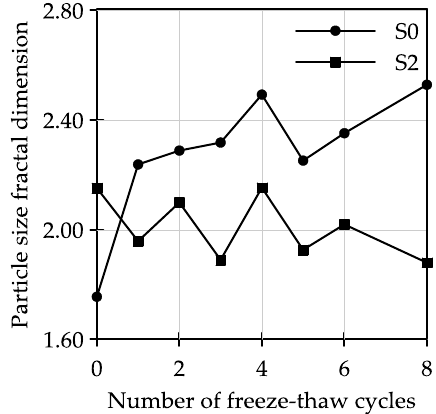
Figure 5. The curve of D ps and F-T cycles.